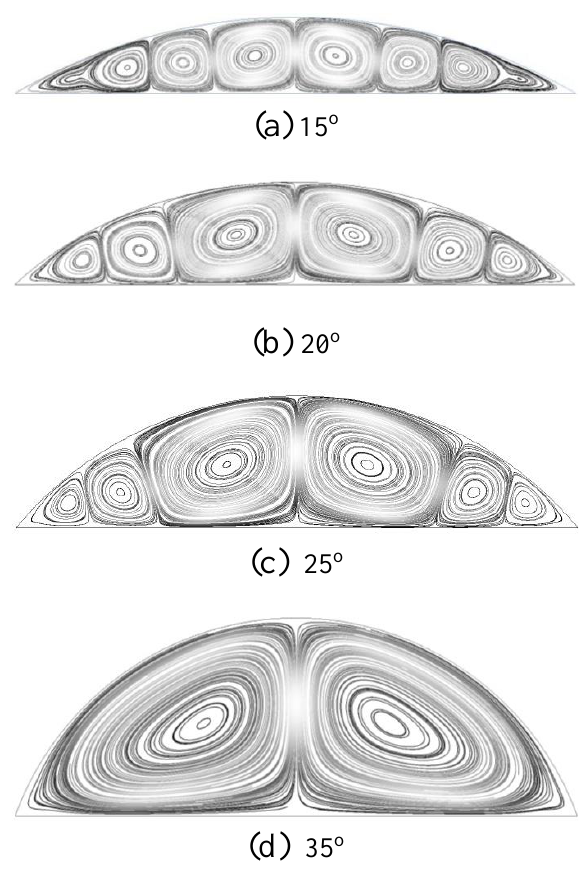
Fig. 3. Streamlines for different roof pitch